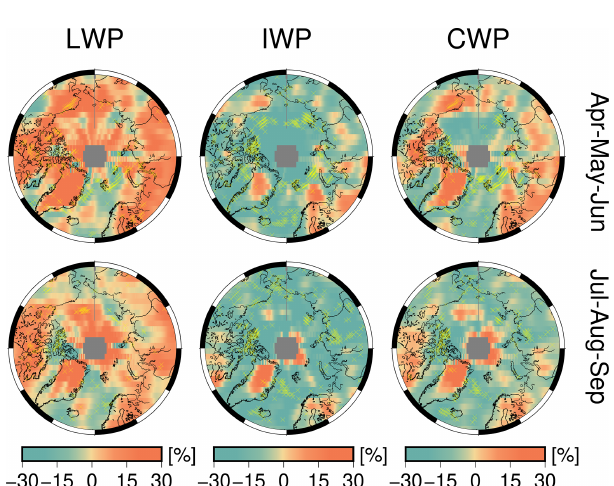
Figure 12. Seasonal total trend, from the first season in the record, of liquid, ice, and total cloud water path (CWP). Stippling in yellow indicates areas of statistical significance at